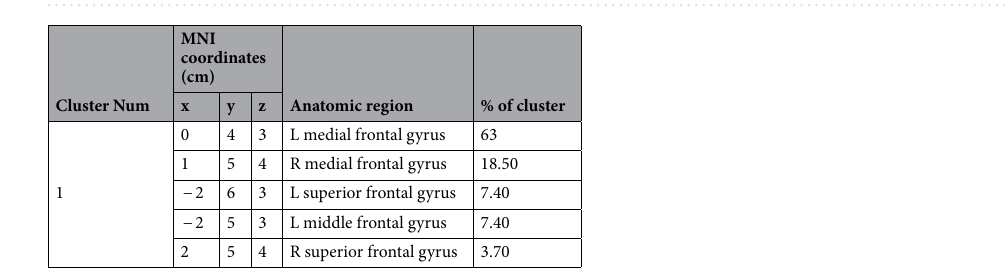
Figure 3. Source-level interaction between OT and PL sessions in the M170 time window. OT increased neural activation in medial frontal regions in response to social stimuli compared to non-social pictures. ( A ) Significant differences in neural activity between social and non-social stimuli were identified based on the t-values. ( B ) The average power of the significant cluster. Lines represent the average activity of the ASD group in each session. Dots represent individual data. ( C ) Source-level activity from a virtual sensor in the significant cluster. The horizontal black line represents the significant time window ( p < .05, corrected for multiple comparisons). Straight lines represent neural activity in social trials, the dashed line represents activity in non-social trials. The color-coding is the same as in panel B.